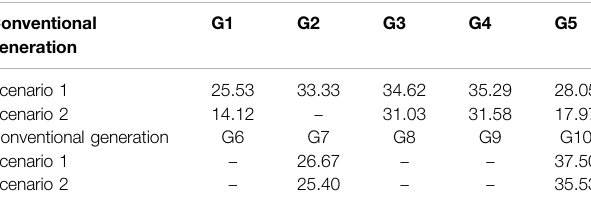
TABLE 2 | The Cost Comparison of Conventional Generations (*10 6 $).